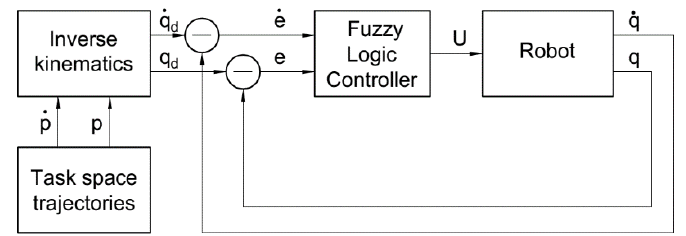
Figure 5. Scheme of fuzzy logic control for the robot–platform system in machining.